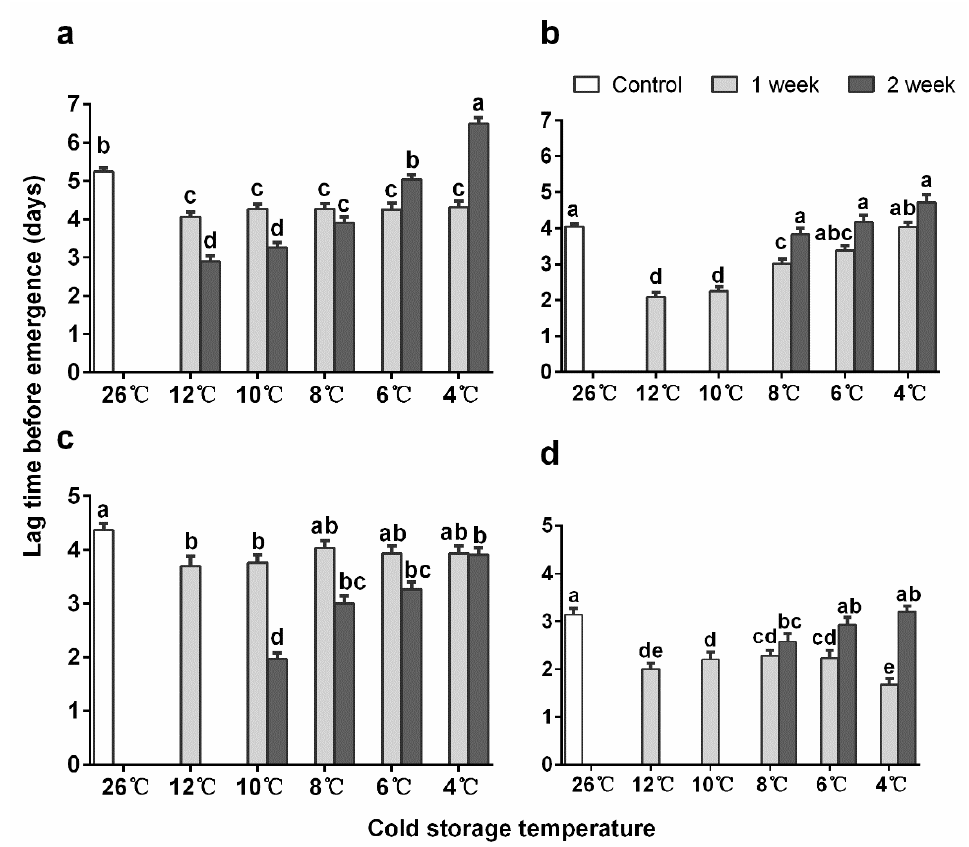
Figure 1. Mean ( + SE) adult emergence time after cold storage of Encarsia sophia and Eretmocerus hayati pupae in different temperatures. ( a ) The 10-day-old pupal stage and ( b ) 12-day-old pupal stage of En. sophia , ( c ) 12-day-old pupal stage and ( d ) 15-day-old pupal stage of Er. hayati . Bar heads with different letters in each cluster indicate significant differences in time before emergence among different storage temperatures. (post-hoc test with Holm correction for multiple comparisons on the linear regression with parasitoid emergence time as the response).